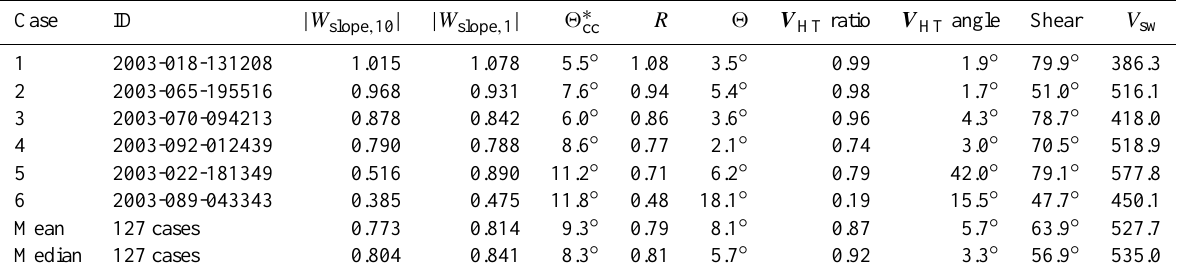
Table 1. Key properties for the six sample cases, plus the means and medians for all 127 cases with good HT frames (HT cc , 1 ≥ 0 . 9). The ID gives the year, day, and UT of the events; | W slope , 10 | and | W slope , 1 | are the Wal´en regression line slope magnitudes for the centered 10 and 1min intervals; 2 ∗ cc is the characteristic angle based on the correlation coefficient W ∗ cc (see Appendix A); R is the ratio between | 1 v | and | 1 V A | , and 2 is the angle between these vectors, computed from 1min averages on the two sides of the DD; the V HT ratio and V HT angle are the magnitude ratio (defined so it is ≤ 1) and angle between the HT velocities, computed for 5min intervals on the two sides of the DDs; the last two columns are the magnetic shear angle across the DDs and the solar wind speed,